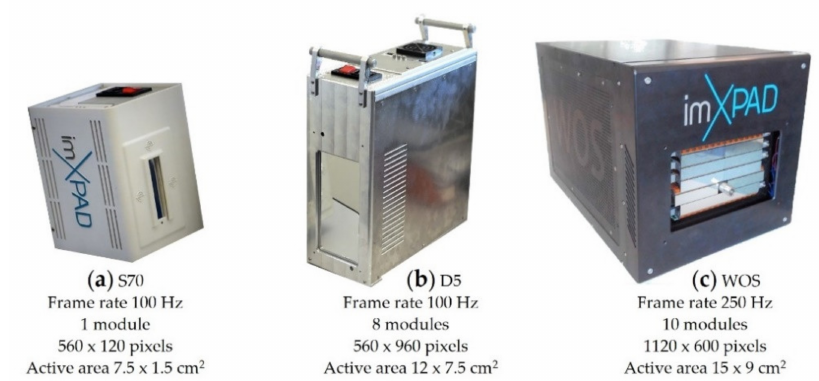
Figure 3. The ImXpad detectors available at the D2AM beamline: ( a ) the S70, ( b ) the D5, and ( c ) the WOS (wide-angle X-ray scattering (WAXS) Open for small-angle X-ray scattering